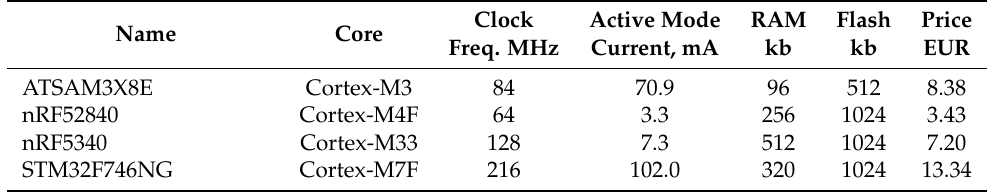
Table 1. Example